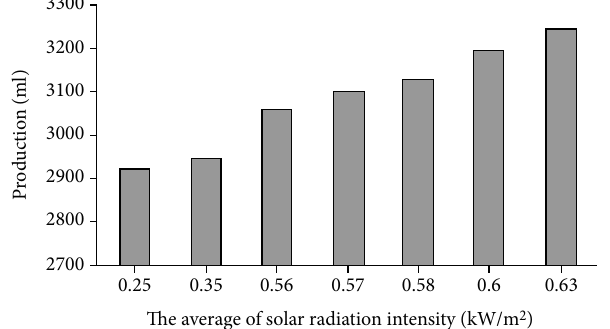
The average of solar radiation intensity (kW/m 2 ) The relation between solar intensity and productivity